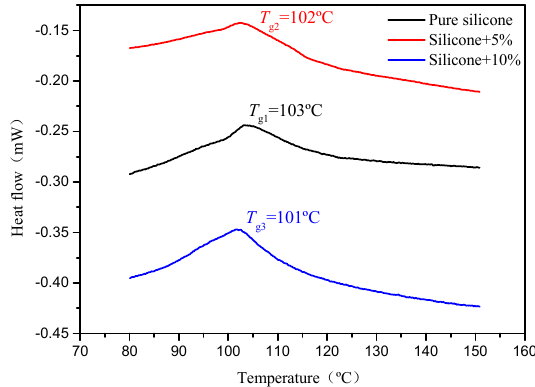
Figure 6. DSC measurement results of pure silicone and phosphor / silicone composites.